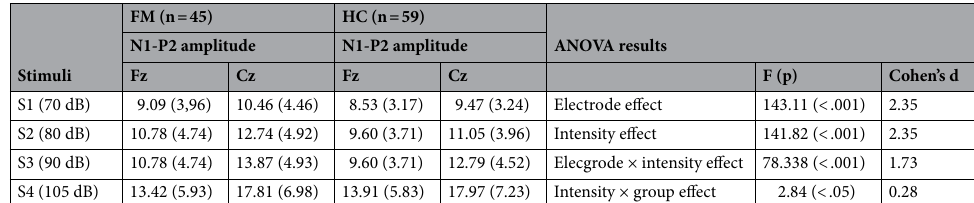
FM (n = 45) HC (n = Stimuli